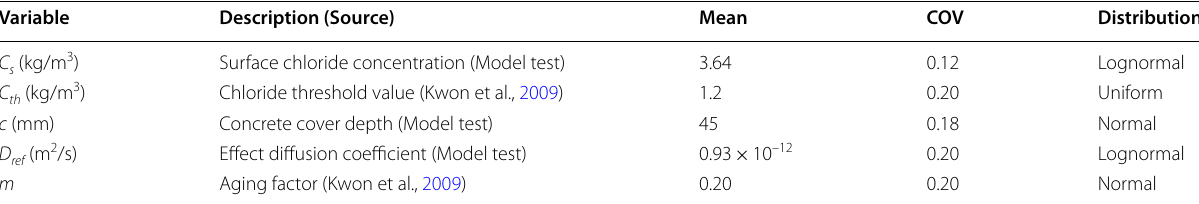
Table 4 Statistical parameters of the random